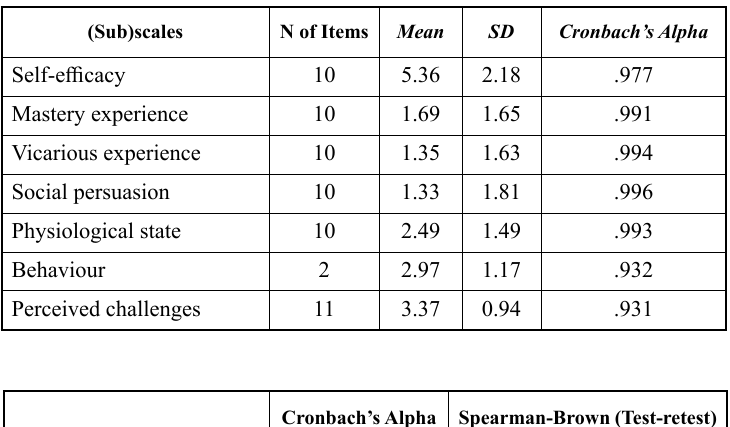
Table 3. The Self-efficacy scale and subscales of the test-retest reliability ( n =